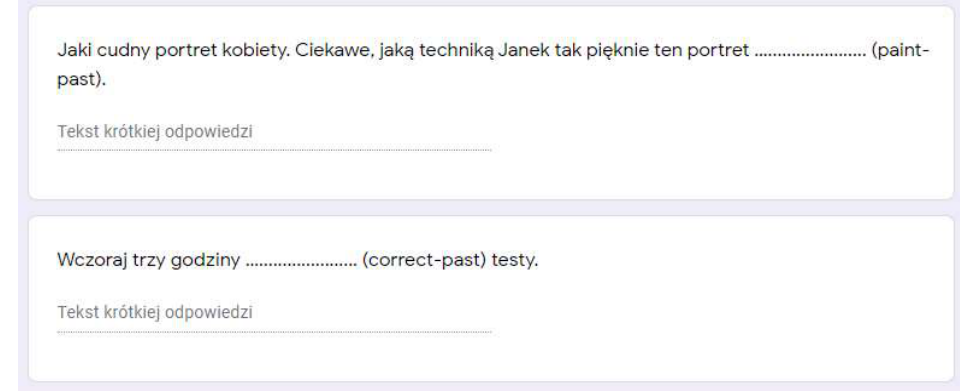
Figure 3. A sample question in the reported online questionnaire.